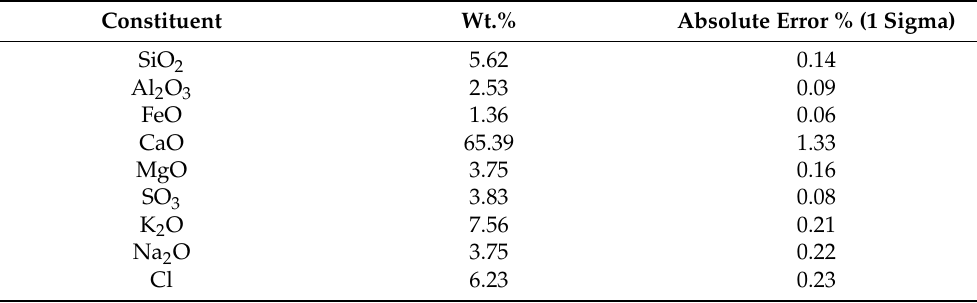
Table 3. Chemical composition of the study cement kiln dust